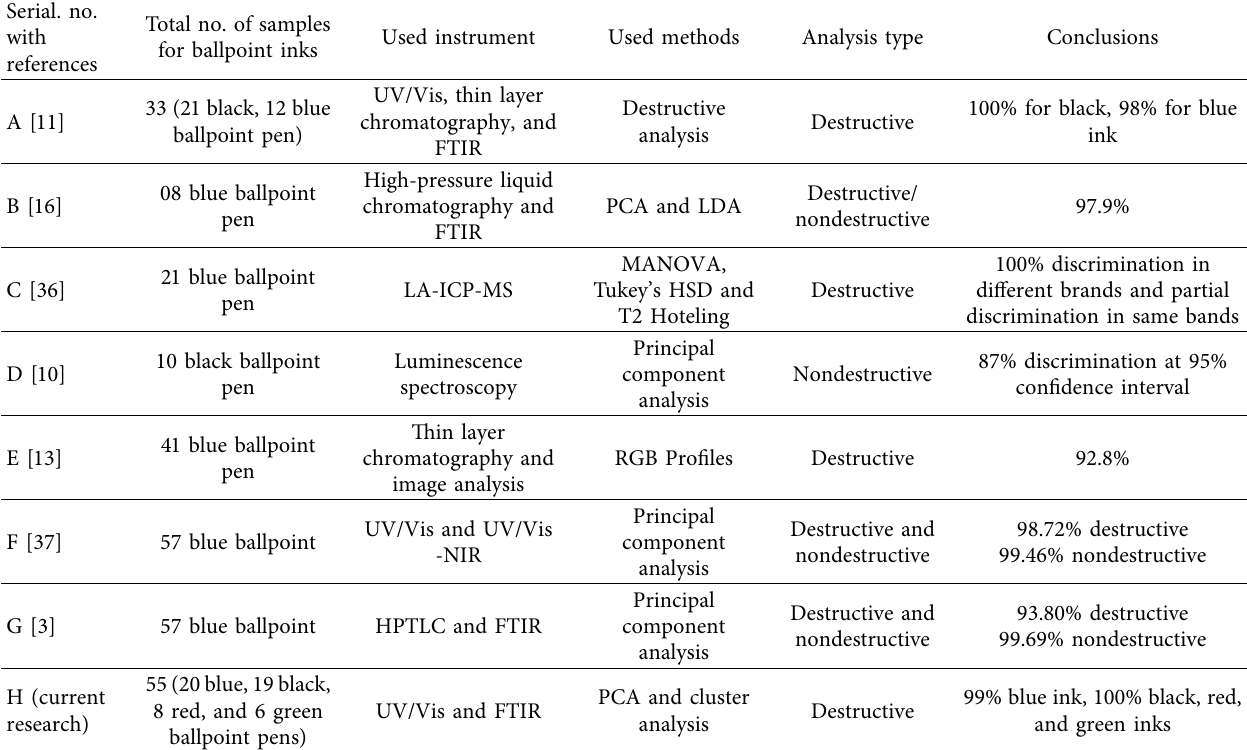
Table 7: Comparison of discrimination for the current study and previously reported studies in the literature. Serial. no.